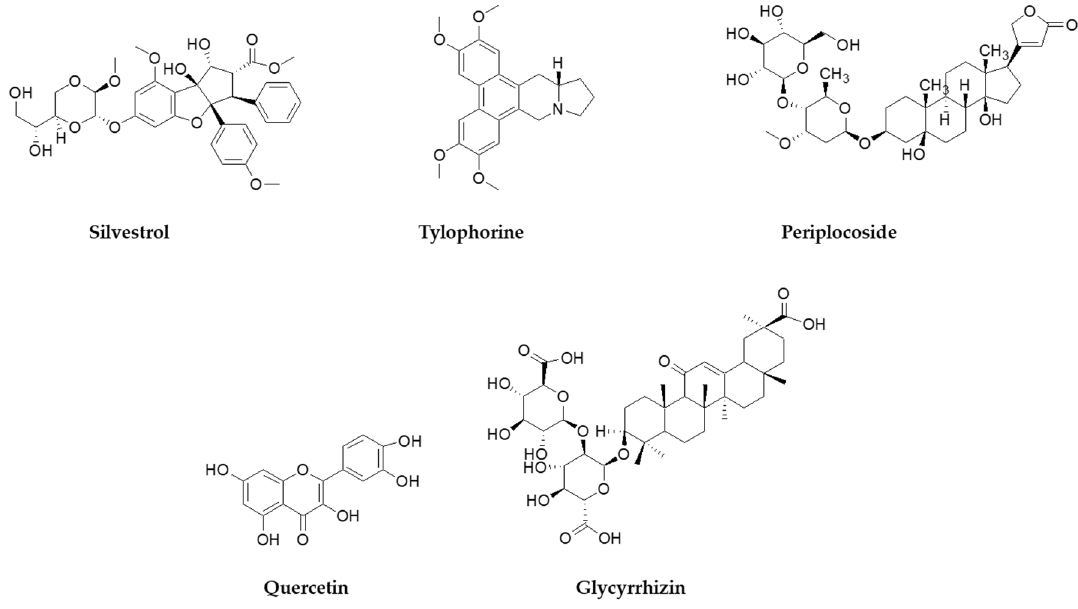
Figure 3. NPs active against HCoVs replication.